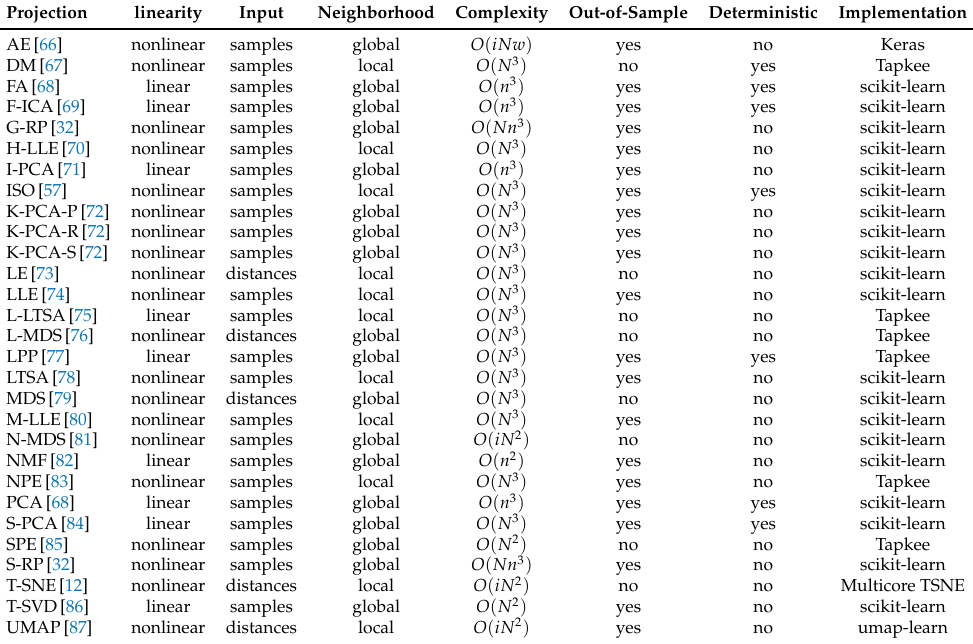
Table 2. Selected projection techniques for evaluation and their characteristics (Section